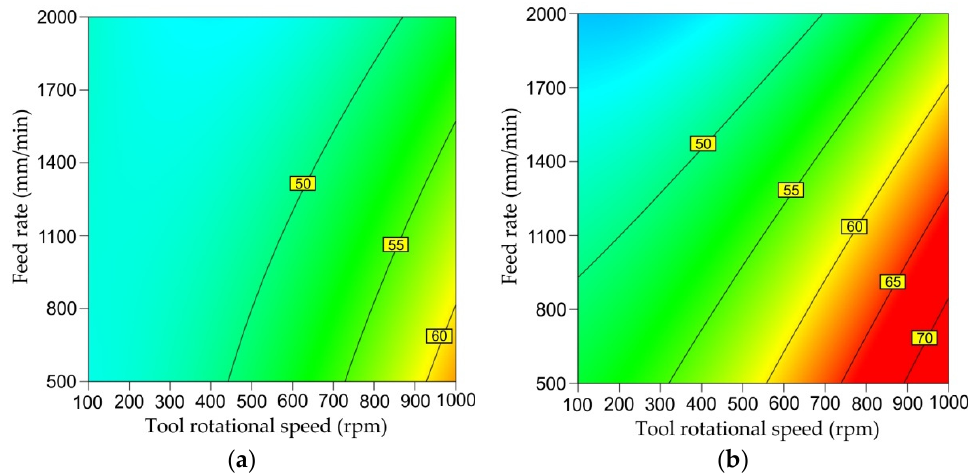
Figure 14. Plots showing the effect of tool rotational speed and feed rate on maximum formable wall angle α max for ( a ) clockwise and ( b ) anticlockwise direction of tool rotation.